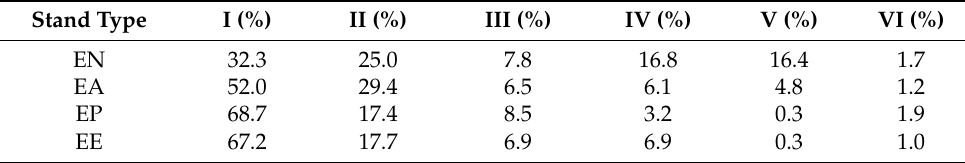
Table 6. Degree of straight-fullness and brunching of tree stems among pure and mixed forests of Eucalyptus .